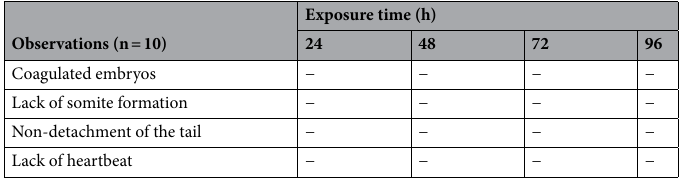
Table 6. Apical observations of acute toxicity in zebrafish embryos for 96 hpf. − = No death; + = Mild; + + = Moderate; + + + = High and + + + + = Severe.